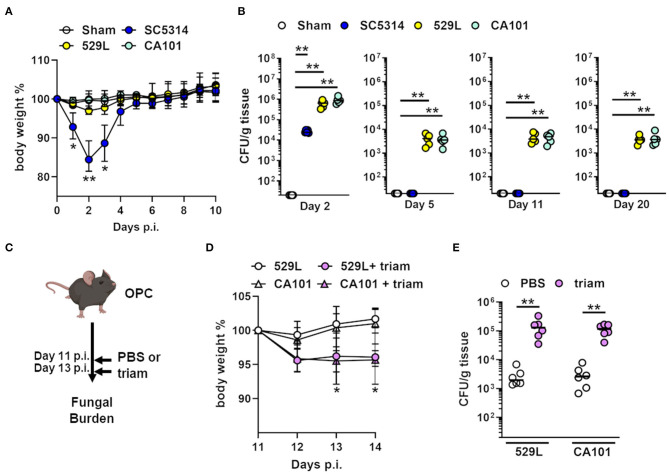
Commensal C. albicans strains cause OPC during immunosuppression. (A) Body weight (mean± range) of mice orally infected with indicated strains. *P < 0.05, **P < 0.01 (n = 10; Mann–Whitney). (B) Oral fungal burden of wild-type mice infected with indicated strains. Results are median of two independent experiments (n = 5). **P < 0.01 (Kruskal-Wallis). The y-axis is set at the limit of detection (20 CFU/g tissue). (C) Mouse model of immunosuppressed OPC during C. albicans colonization. Triam, triamcinolone. (D) Body weight (mean ± range) of mice starting day 11 during fungal colonization and immunosuppression. Day 11 post infection set as 100%. (E) Oral fungal burden of wild-type mice infected with indicated commensal strains 11 days post oral infection. Results are median of two independent experiments (n = 6). **P < 0.01 (Mann-Whitney). The y-axis is set at the limit of detection (20 CFU/g tissue).